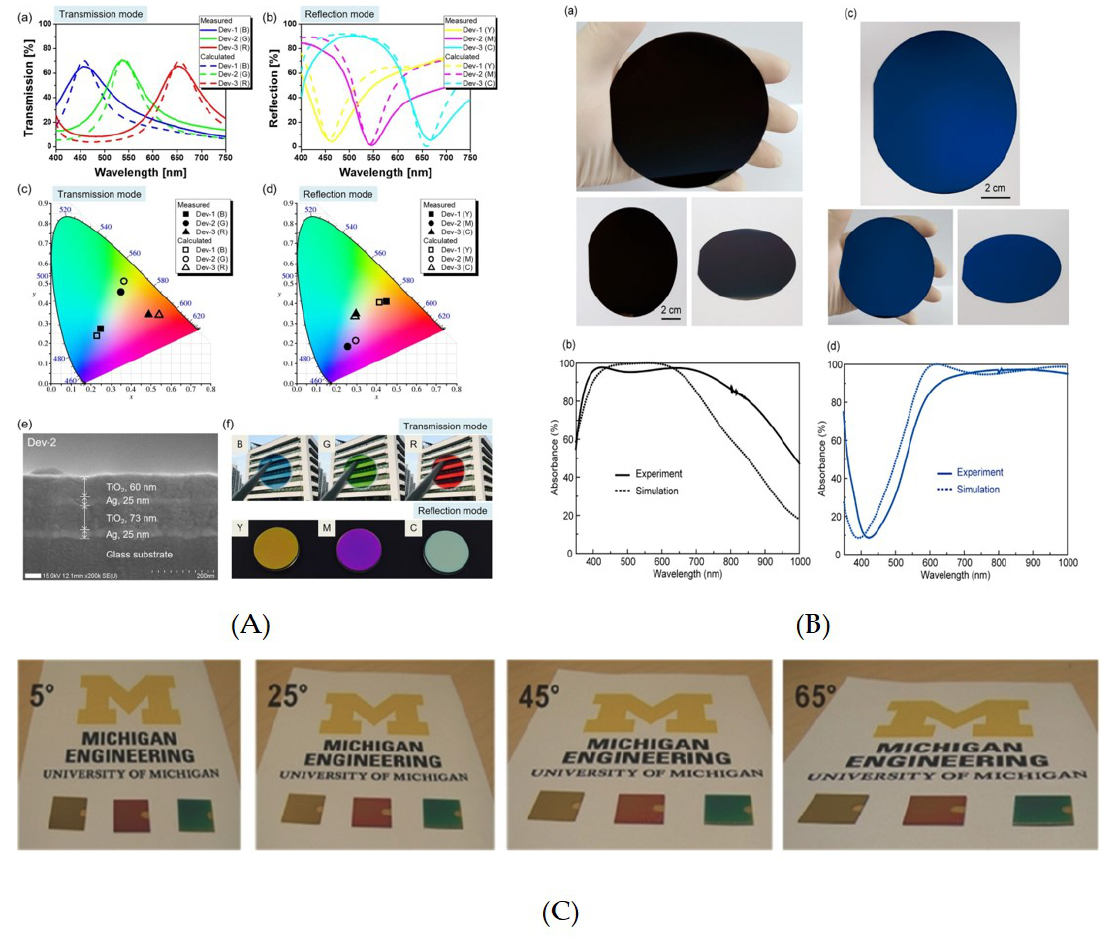
Figure 2. ( A ) Calculated and measured transmission and reflection spectra for the three fabricated devices shows RGB in transmission and CMY in reflection mode. The CIE 1931 further provides the coordinates of the produced results [12]. ( B ) Calculated and measured spectra along with the camera images of broadband visible and near-infrared absorbers implemented with planar nanolayered